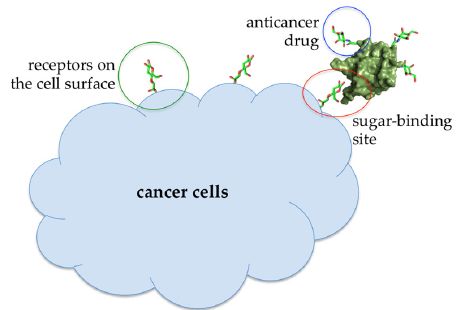
Figure 7. Illustration of an Abmb bioconjugate carrying an anticancer drug upon recognition by a receptor (presumably a sugar) on the cell surface.